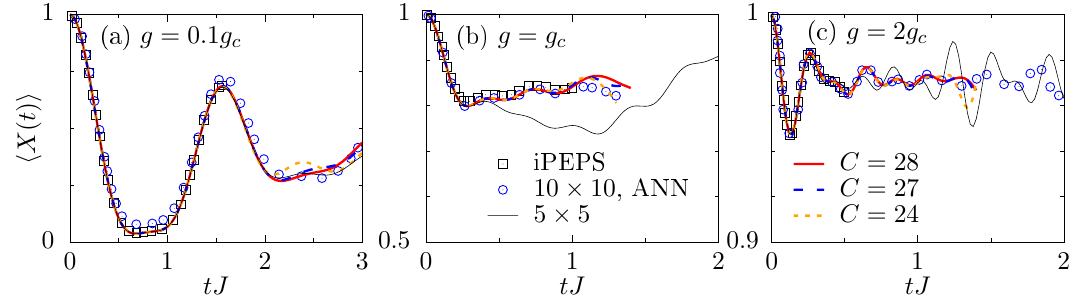
Figure 7: Dynamics of the transverse magnetization 〈 X ( t ) 〉 for two-dimensional lat- tices with initial state | ψ ( 0 ) 〉 = |→〉 and transverse fields (a) g = 0.1 g and (c) g = 2 g . Data obtained by NLCE for expansion orders C = 24,27,28 are com- c pared to the simulation of a 5 × 5 lattice with PBC. Additionally, we show iPEPS data digitized from Ref. [ 52 ] and ANN data for a 10 × 10 lattice digitized from Ref. [ 56 ]